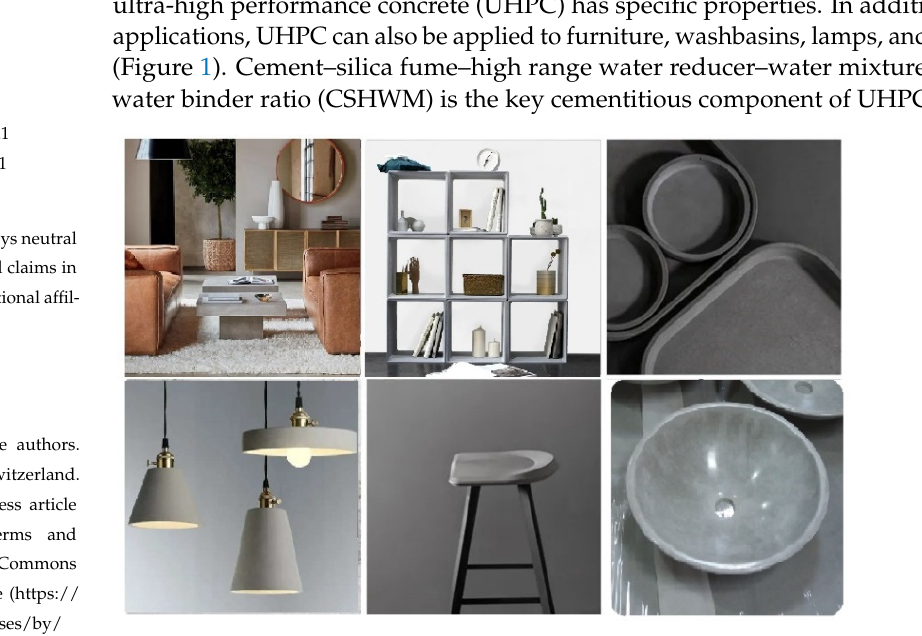
Figure 1. The products of UHPC.